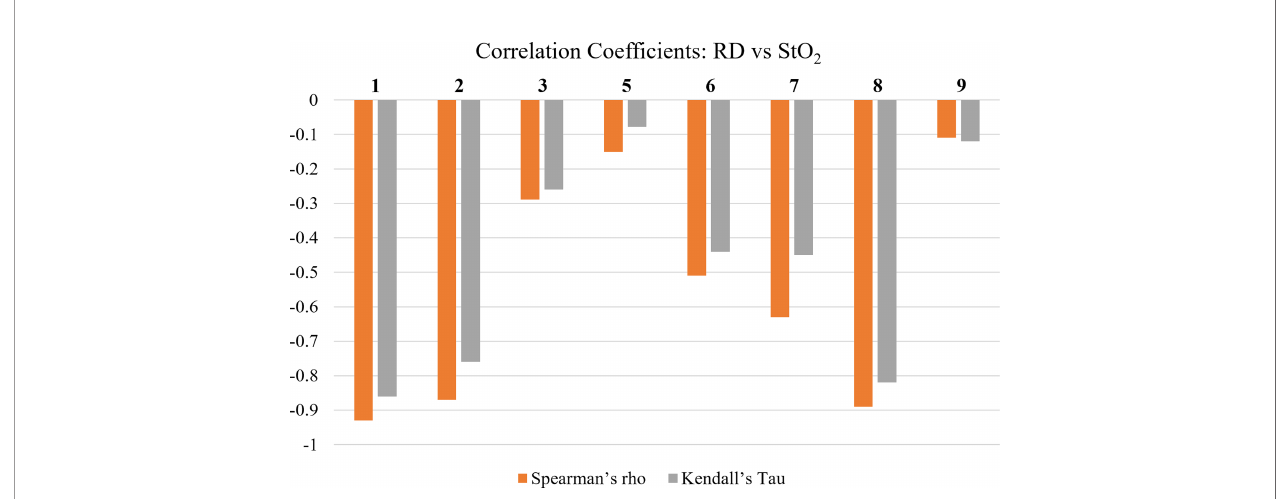
FIGURE 6 | Spearman ’ s Rho ’ s and Kendall ’ s Tau ’ s correlation coef fi cients between average oxygen saturation (StO 2 ) and RD grading. Patients 4 and 10 had no reported RD grading during RT and were therefore omitted from this